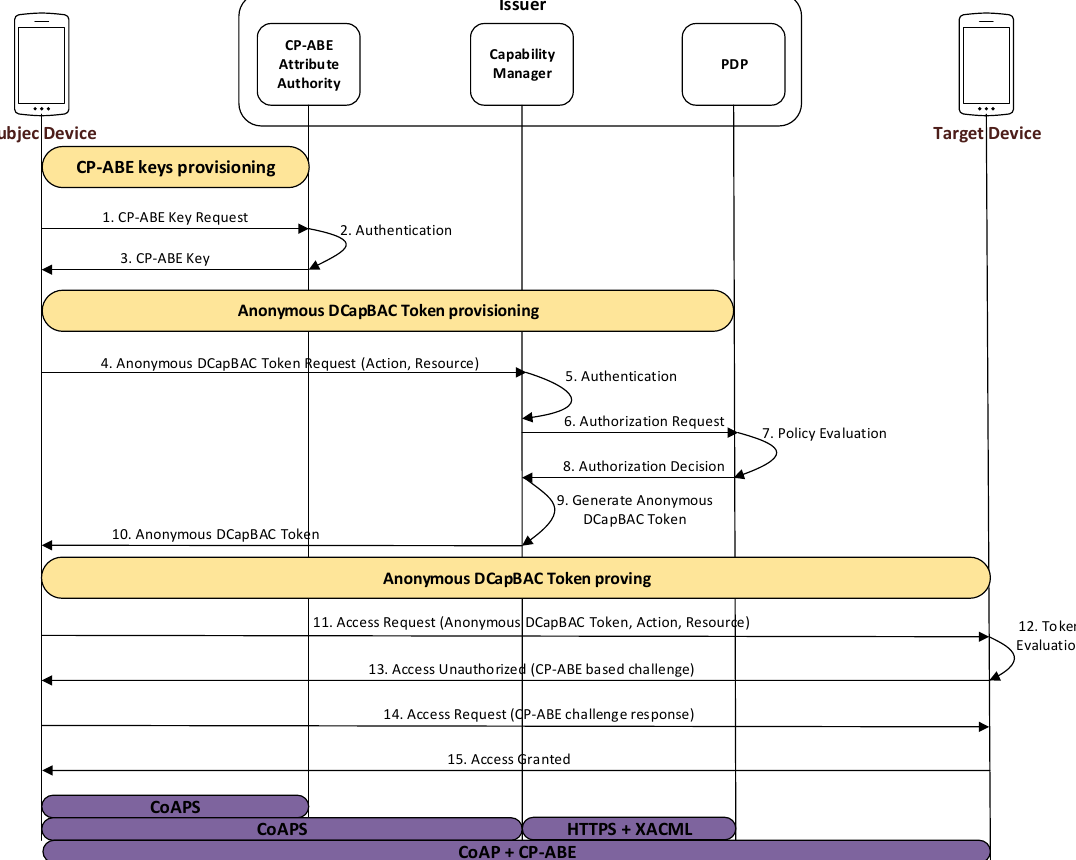
Ciphertext-Policy Attribute-Based Encryption (CP-ABE) based Anonymous DCapBAC